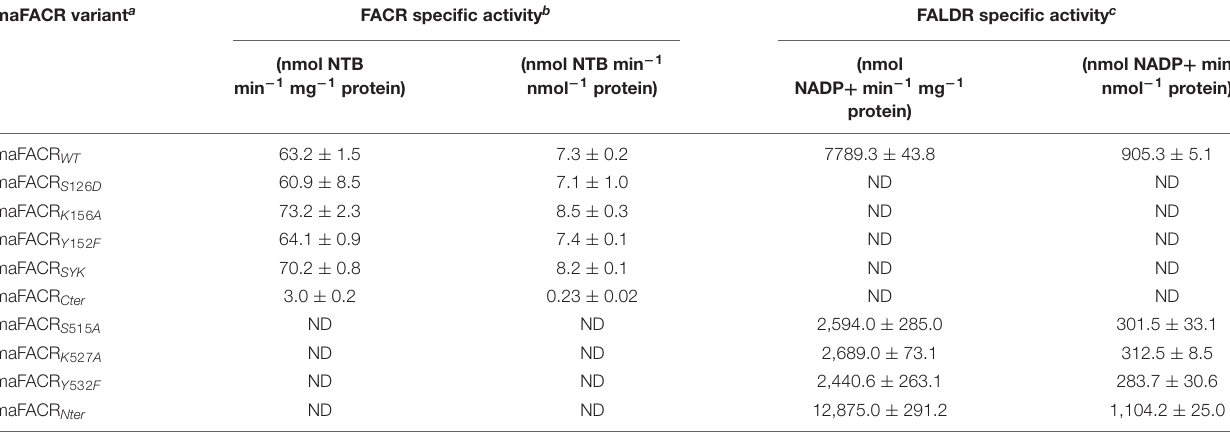
TABLE 1 | In vitro assay of FACR and FALDR activities in maFACR